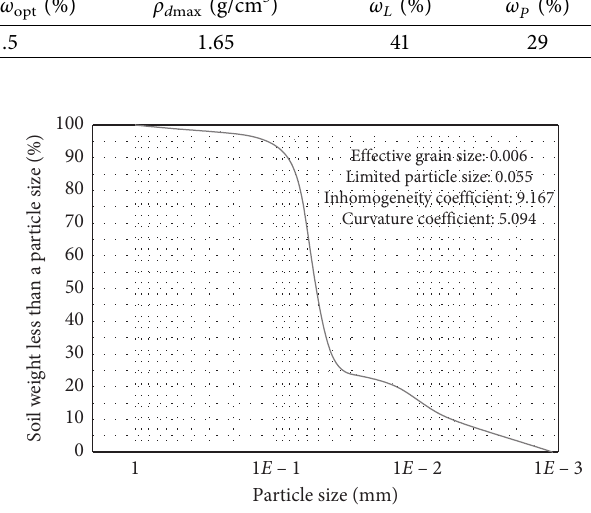
Figure 1: Curve of the grain size distribution.